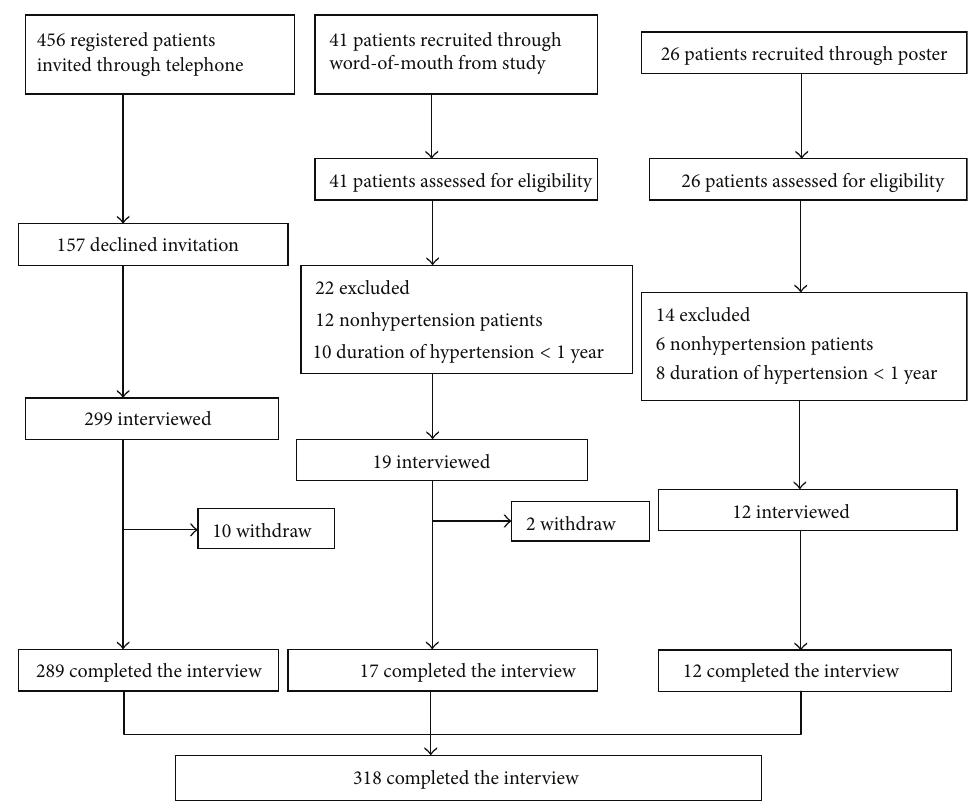
Figure 1: Participation rate and study cohort of survey on self-care behaviors in a rural hypertension population in Beijing, China.